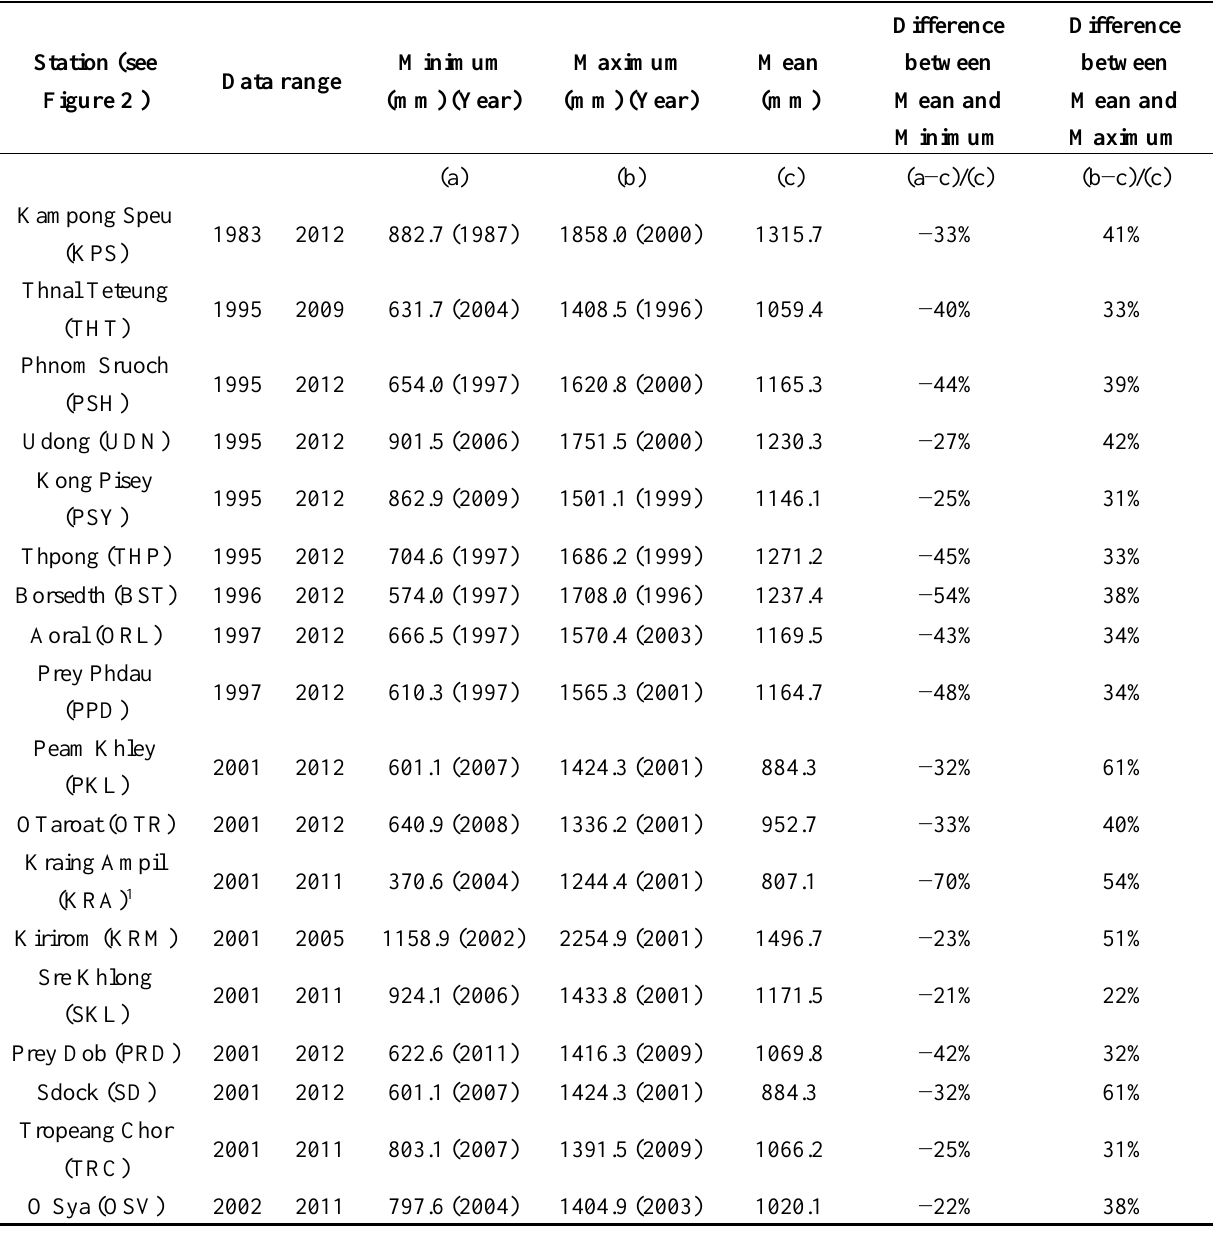
Table 1. Rainfall statistics: Kampong Speu